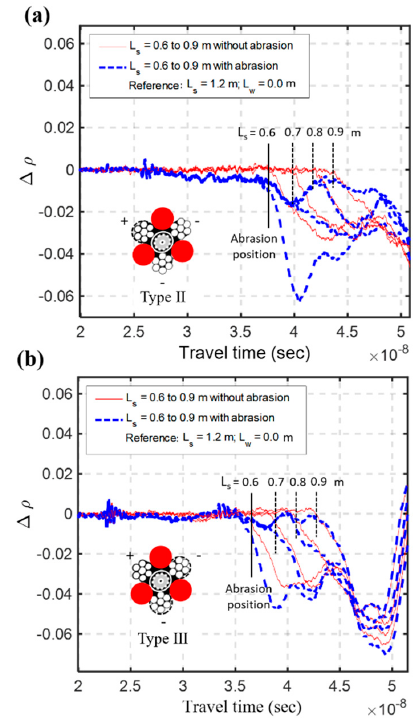
Figure 7. The effect of coating abrasion after sediment refilling for Type II waveguide ( a ) and Type III waveguide ( b ).